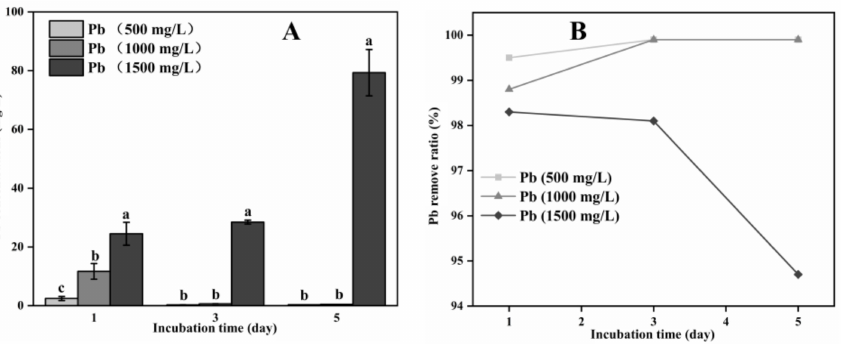
Figure 2. Pb concentrations in the medium ( A ) and Pb remove ratio ( B ) in different lead concentrations during the incubation time (1, 3, and 5 days). The error bars represent the standard deviations of three replicates for each treatment. The different lower-case letters indicate a significant difference between the treatments ( p <